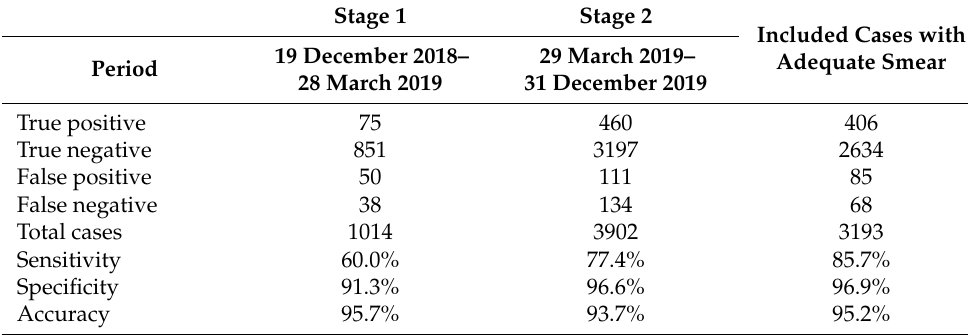
Table 1. The performance of the automated TB smear microscopy system.